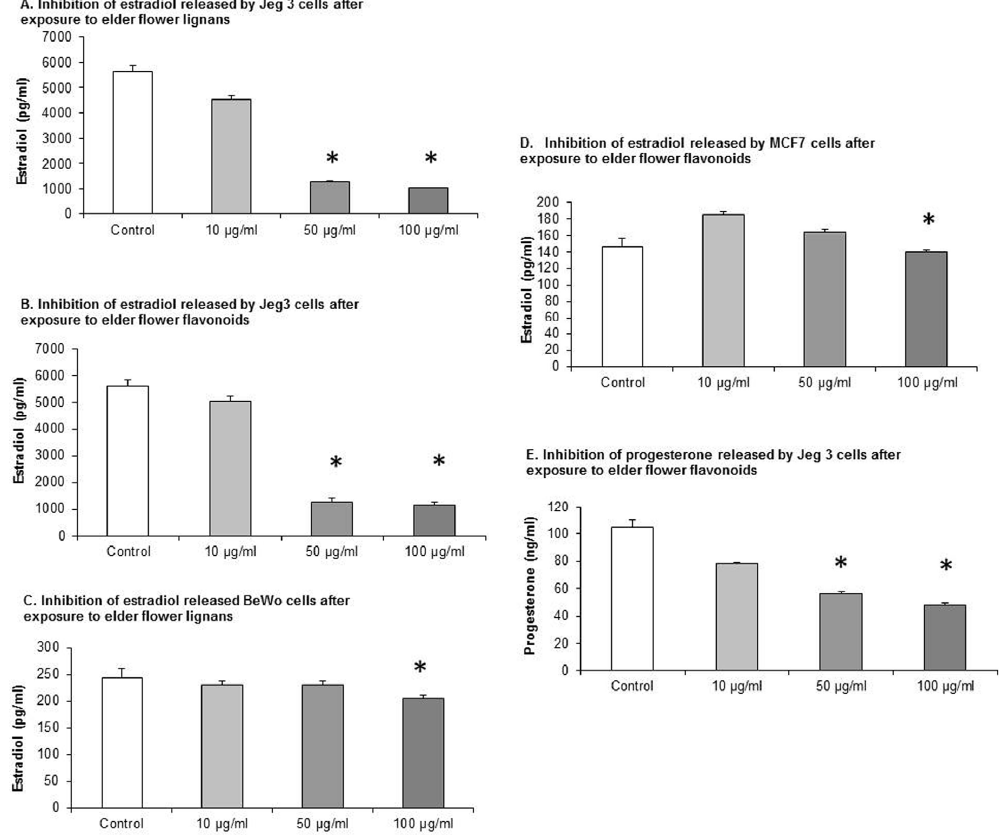
Figure 2. Estradiol and progesterone concentration in the tissue culture medium of JEG ‐ 3, BeWo, and MCF7 cells in the absence or presence of EFE. The effective EFE concentrations were 10 μ g/mL, 50 μ g/mL, and 100 μ g/mL. Significantly different observations are highlighted with an asterisk.